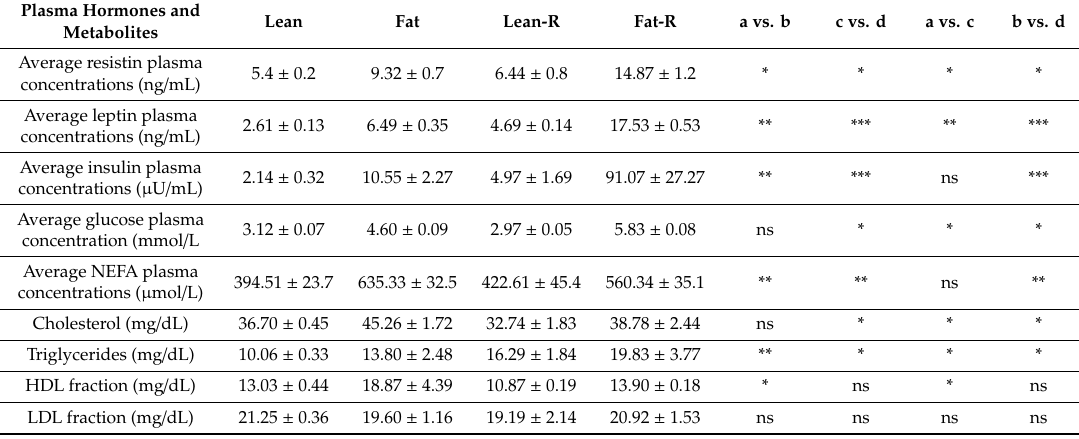
Table 1. Plasma concentrations (mean ± SEM) of metabolic parameters (resistin, leptin, insulin, glucose, nonesterified fatty acids (NEFAs), cholesterol, triglycerides, high-density lipoprotein (HDL) and low-density lipoprotein (LDL) in nontreated (Lean and Fat) animals and animals treated with recombinant bovine resistin (Lean-R [Lean-Resistin treated] and Fat-R [Fat-Resistin treated]; n = 5) after 5 months of body weight alterations ( n = 5 per group). Plasma Hormones and Lean Fat Lean-R Fat-R a vs. b c vs. d b vs. d Metabolites Average resistin plasma 5.4 ± 0.2 concentrations (ng / mL) Average leptin plasma concentrations (ng / mL) Average insulin plasma concentrations ( µ U / mL) Average glucose plasma concentration (mmol / L Average NEFA plasma concentrations ( µ mol / L) Cholesterol (mg / dL) HDL fraction (mg / dL)